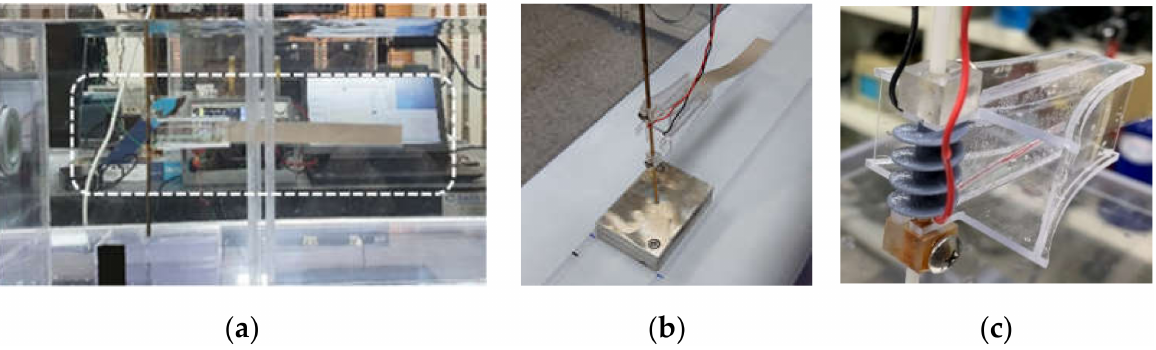
Figure 17. FTEH and experimental set up: ( a ) side view of the FTEH; ( b ) FTEH fixed in rail shape; ( c ) FTEH with spiral structure mounted on the harvester